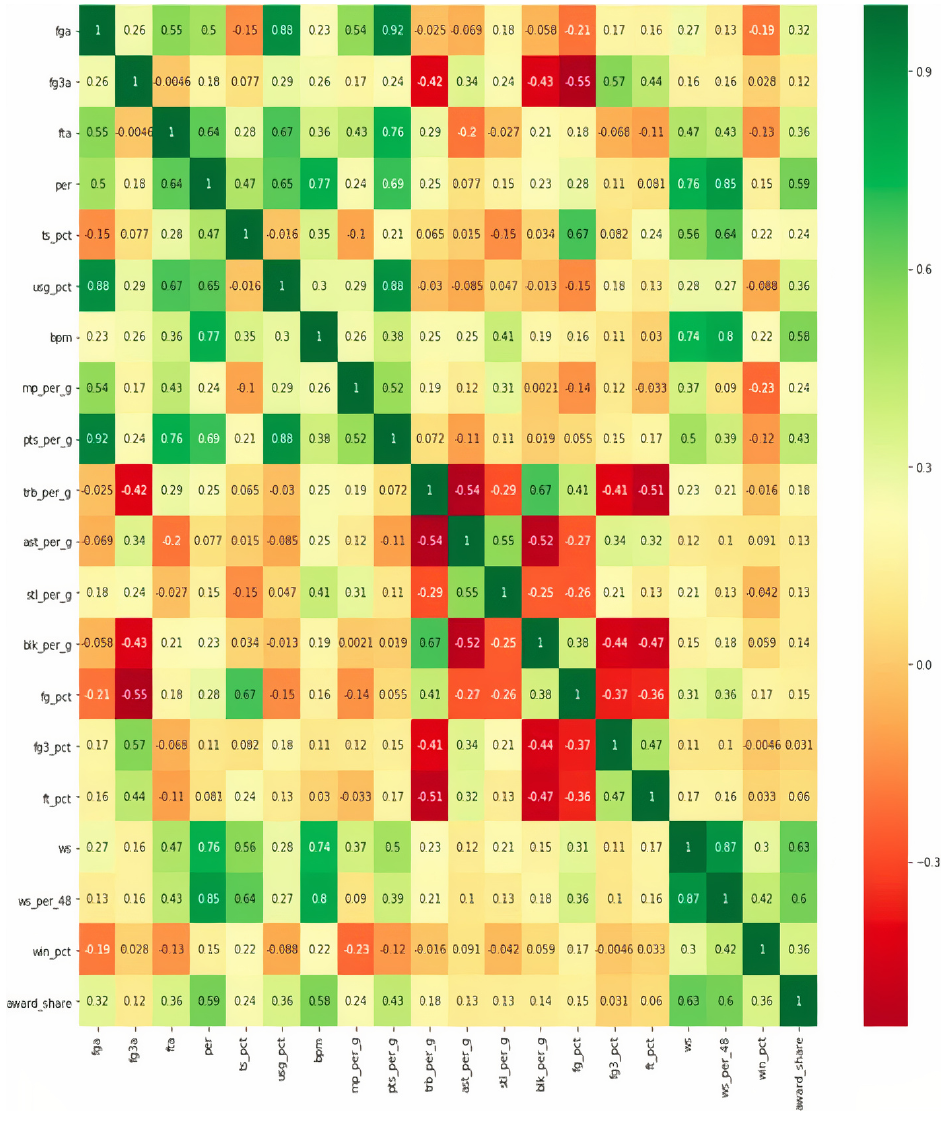
Figure 1. Confusion matrix of a multifeatured model based on the MVP